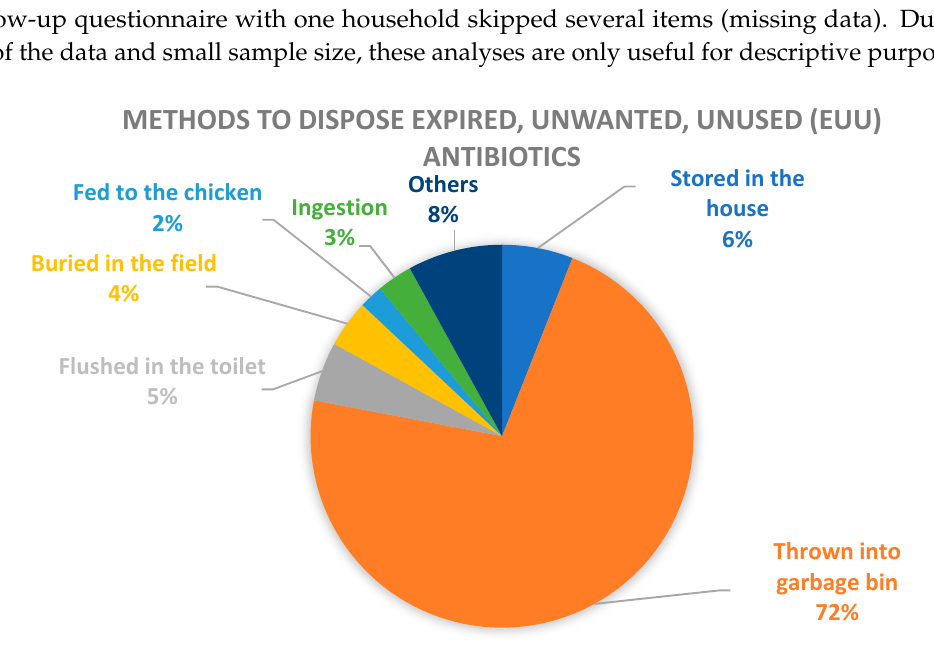
Figure 1. Methods to dispose expired, unwanted or unused (EUU) antibiotics. Table 2. Awareness of the danger of antibiotic resistance and unsafe disposal and associated practices among community panels.